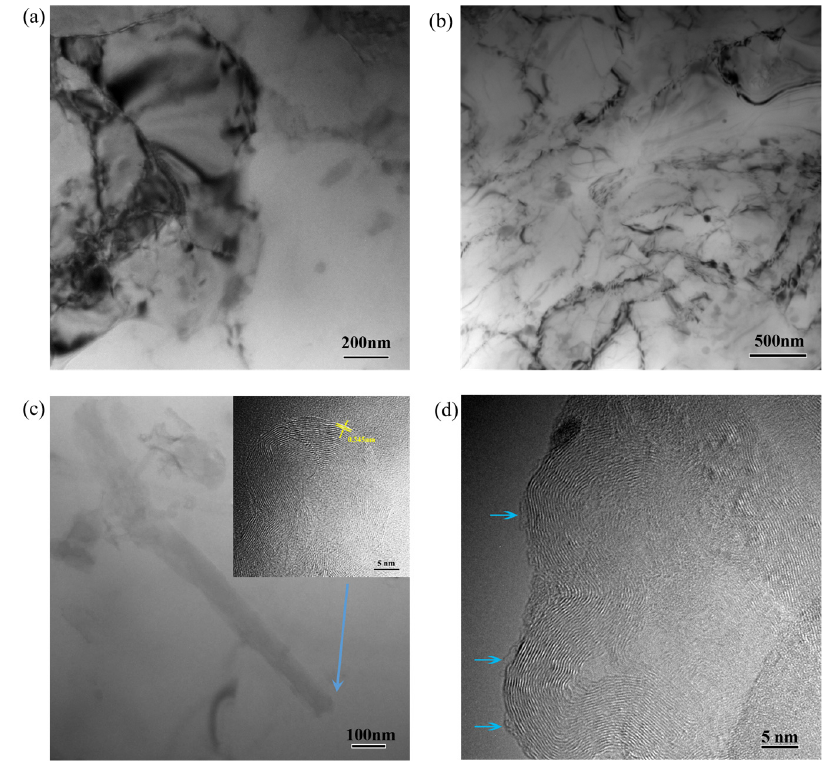
Figure 3. Typical TEM images of Al/1.0 vol.% CNTs nanocomposites processed by 12 ARB cycles. ( a ) Substructures in Al matrix; ( b ) deformed structures in Al matrix; ( c ) individual MWCNT within Al grain; ( d ) MWCNT cluster at grain boundary.